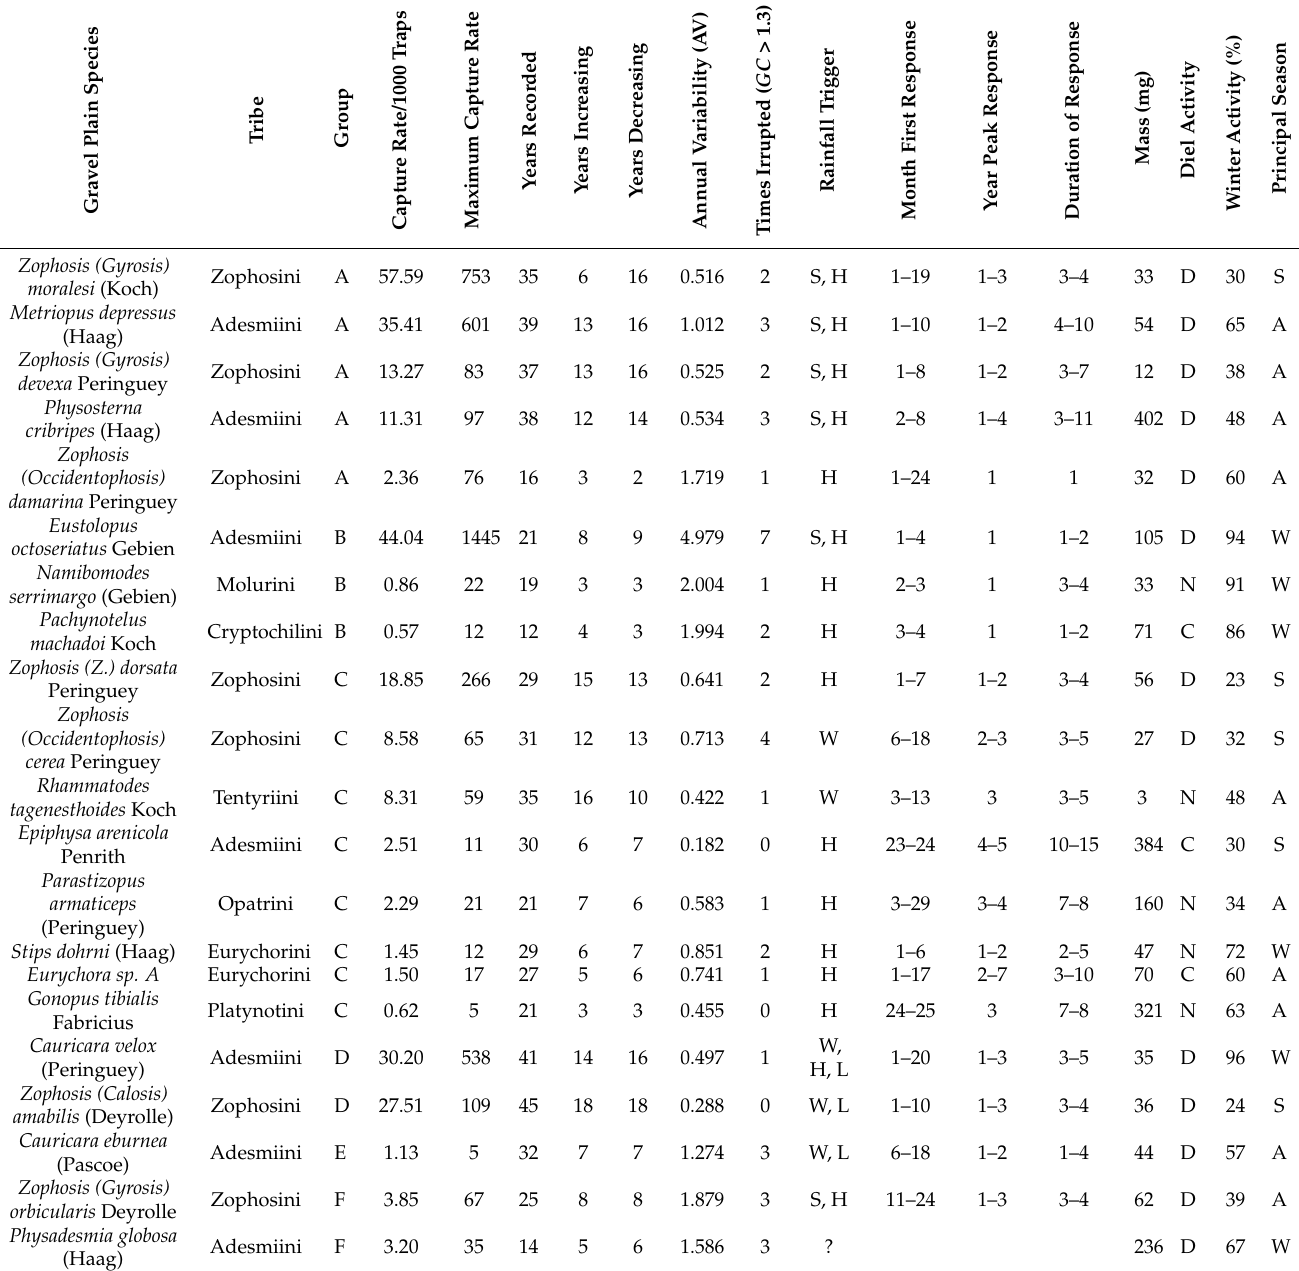
Table 1. Abundance measures of focal species [69]: average and maximum trap rate per 1000 trap days, the number of years in which species were recorded and populations increased ( GC > 0.05) or decreased ( GC < − 0.05), annual variation (AV), the number of population irruptions ( GC > 1.3) recorded over the study period. The next set of columns describes which kind of rainfall triggered population increases (S = effective rainfall in summer, Oct–Mar; W = effective rainfall in winter, April–September; H = heavy rainfall, >40 mm; L = light rainfall, <11 mm), the number of months for the population to show first consistent response, the number of years to reach a peak and the number of years until the end of a response. The right columns are characteristics of the species: dry body mass (mg) [73], diel activity (D = diurnal, N = nocturnal, C = crepuscular) [64,68], and the principal season of activity according to winter records (<33% = summer (S), >66% = winter (W), 33–66 = aseasonal